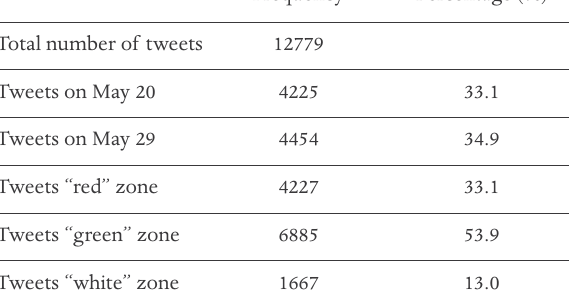
Table 2. Tweets written during the May-June 2012 seismic sequence in Emilia according to users locations (red, green and white zones).